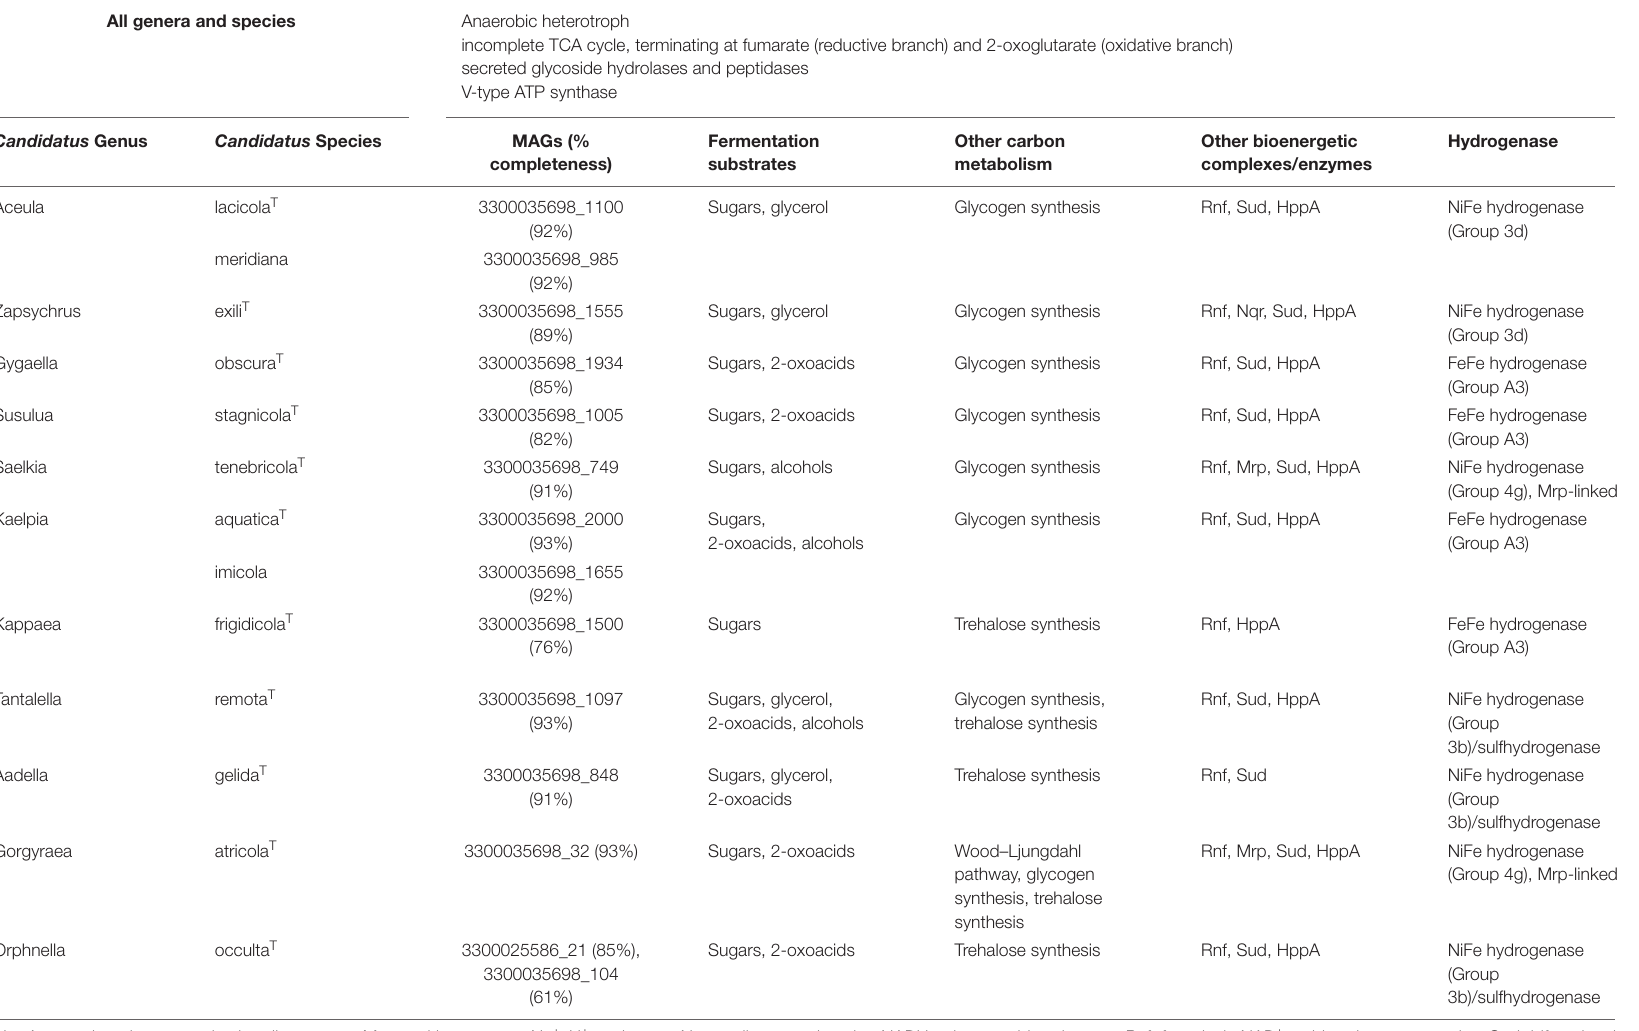
TABLE 2 | Metabolic capacity of the Ace Lake Omnitrophota inferred from metagenome-assembled genomes